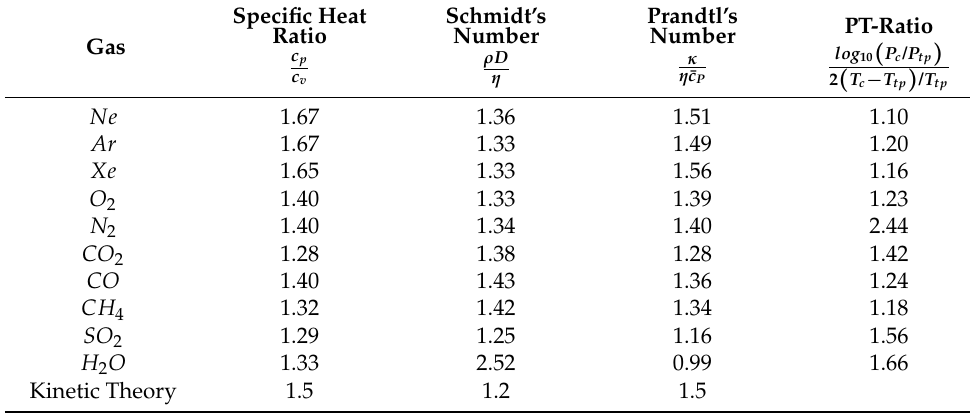
Table 3. Dimensionless ratios of thermodynamic quantities for simple gases.